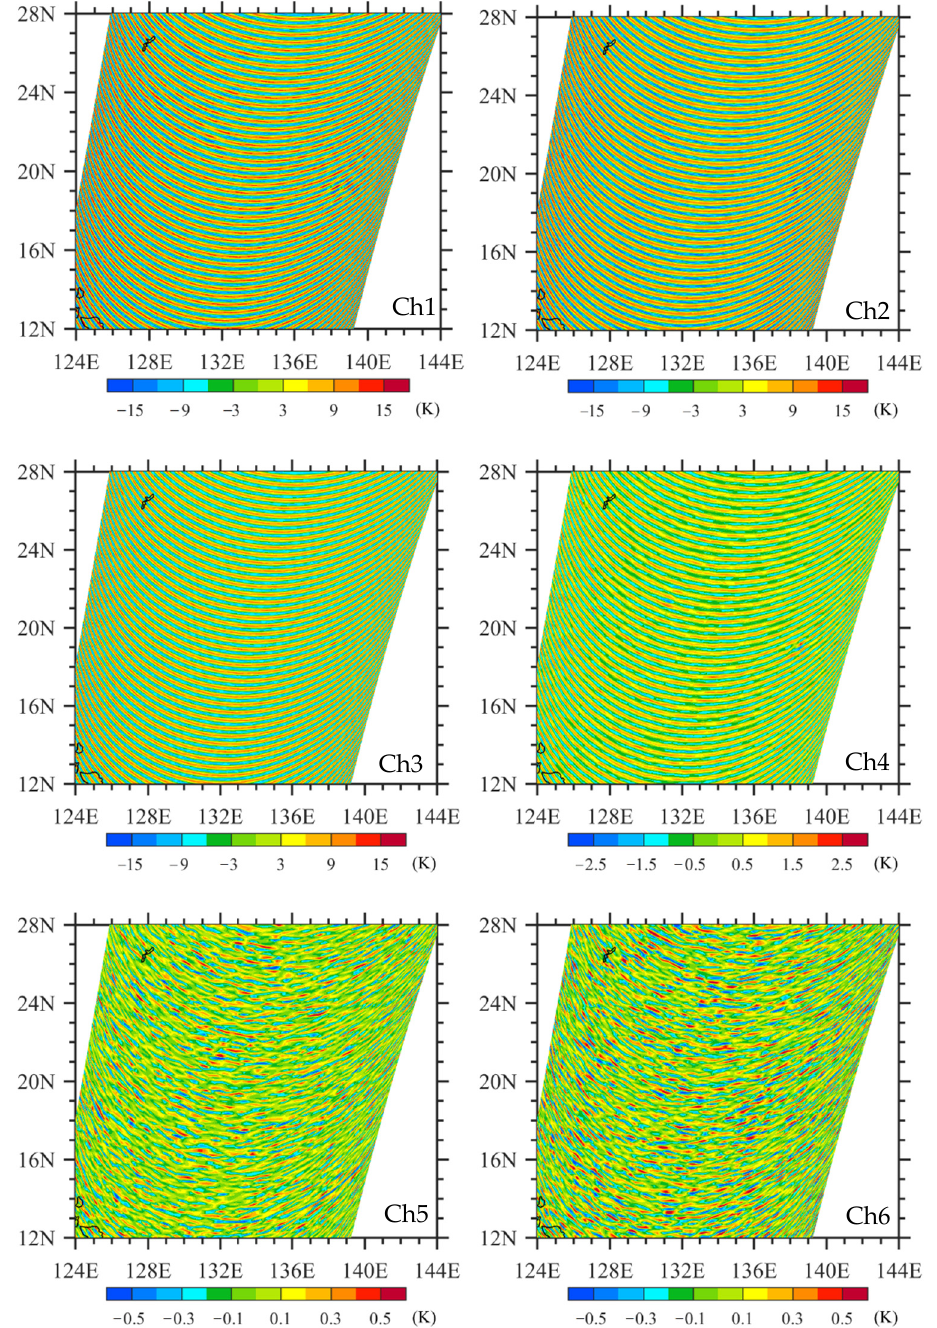
Figure 6. The along-track high-frequency noise in TB observations at channels 1–7 and 24 with frequencies higher than 0.07 s − 1 .